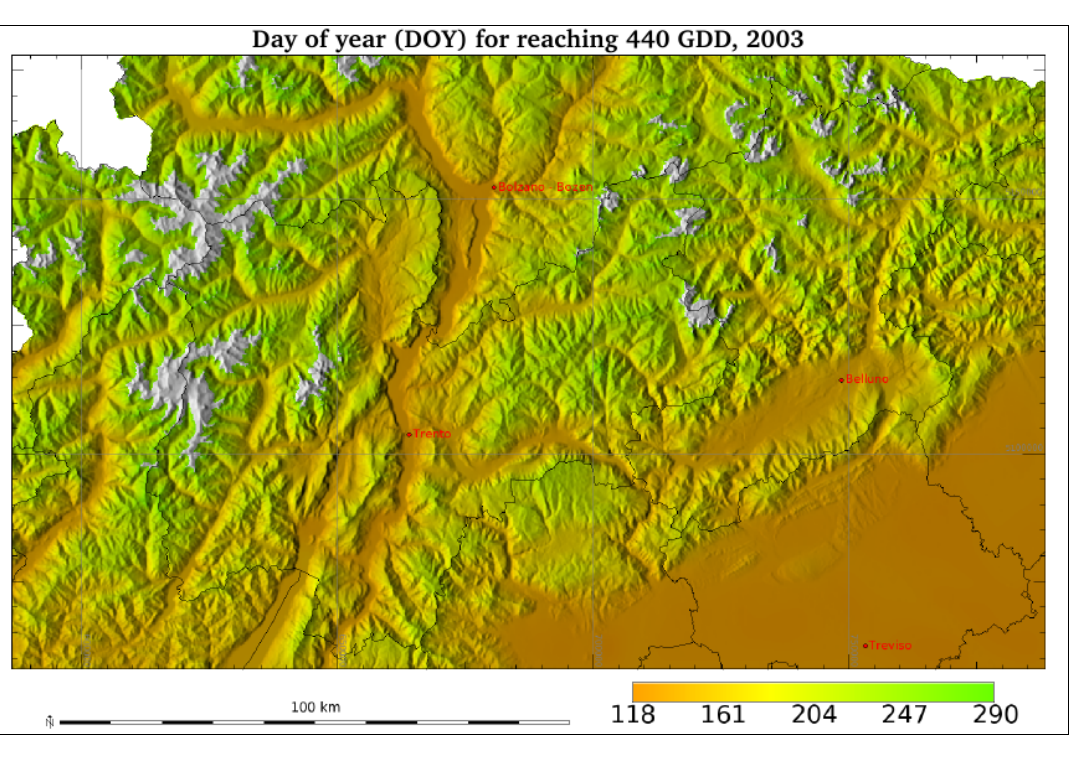
Figure 8. Number of days of the year (DOY) to reach 440 accumulated growing degree days in the year 2003 (baseline temperature: 10 °C, cut-off temperature: 30 °C). The threshold is reached earliest in the year on the valley floors and the Po river plain, later or not at all in higher altitudes (uncolored zones; map scale